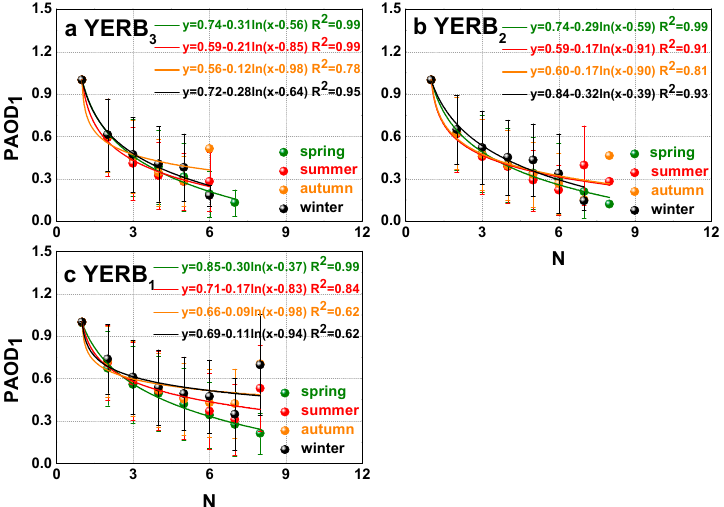
Figure 8. The correlations between PAOD 1 and layer amount (N) over TP. Where ( a ) is for YERB 3 , ( b ) is for YERB 2 , and ( c ) is for YERB 1 .